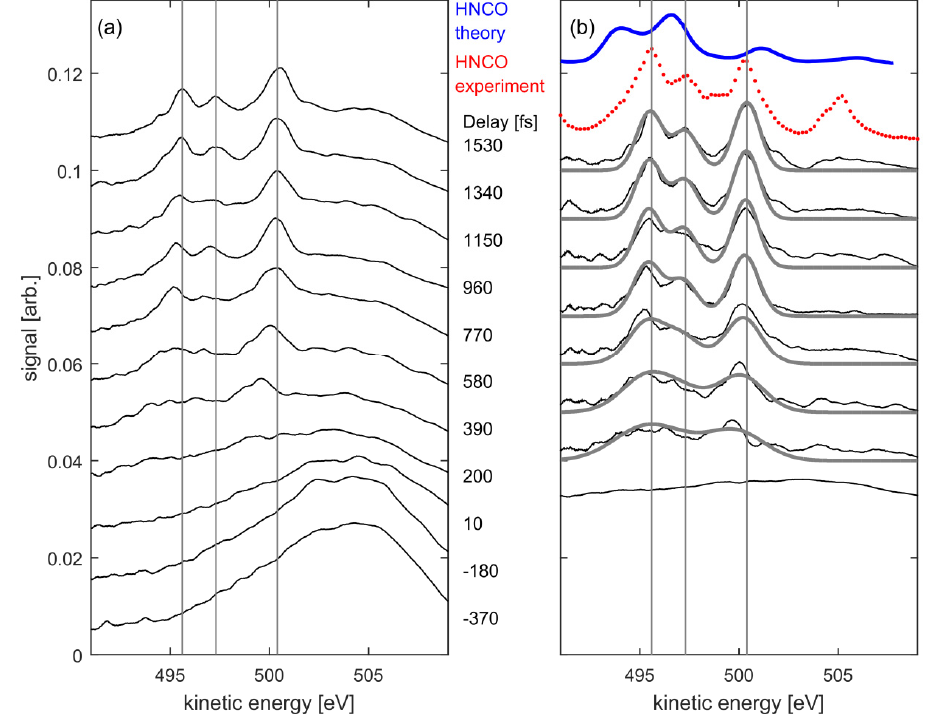
Figure 3. Results of the transient Auger studies on fragmenting thymine ions. ( a ) The Auger spectra of the UV ‐ fragmented molecules are shown as a function of delay between the UV and soft X ‐ ray pulse. Narrow lines appear on a broadening baseline with increasing delay. The three vertical grey lines indicate the position of peak maxima for long delays, showing that the narrow lines shift towards higher energies with increasing delay. The time ‐ resolved data is synthesized from single FEL shots. The relative error of the spectral intensity on is on the order of 5–10%, which was determined in another paper on data from the same lincac coherent light source experiment using bootstrap statistical analysis [17]. ( b ) The same transient spectra as in ( a ), corrected by a background (see text). For large delays, the transient spectrum fits the reference HNCO spectrum taken at the synchrotron (red dots). The relative intensity error in the significant range is on the order of a few percent. The calculation indicated in blue reproduces all the essential features of the HNCO reference spectrum, although with slightly different peak distances. The thick grey lines model the transient spectra by shifting and broadening three Gaussian lines according to a one ‐ dimensional fragmentation process as described in the text.